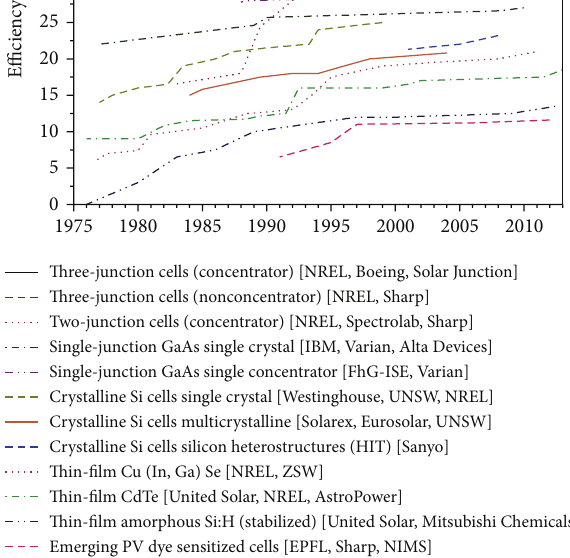
Figure 5: PV efficiency versus year of development [exam- ples of developers]. Three-junction cells (concentrator) [NREL, Boeing, Solar Junction], three-junction cells (nonconcentrator) [NREL, Sharp], two-junction cells (concentrator) [NREL, Spec- trolab, Sharp], single-junction GaAs single crystal [IBM, Varian, Alta Devices], single-junction GaAs single concentrator [FhG-ISE, Varian], crystalline Si cells single crystal [Westinghouse, UNSW, NREL], crystalline Si cells multicrystalline [Solarex, Eurosolar, UNSW], crystalline Si cells silicon heterostructures (HIT) [Sanyo], thin-film Cu (In, Ga) Se [NREL, ZSW], thin-film CdTe [United Solar, NREL, AstroPower], thin-film amorphous Si:H (stabilized) [United Solar, Mitsubishi Chemicals], and emerging PV dye sensi- tized cells [EPFL, Sharp,